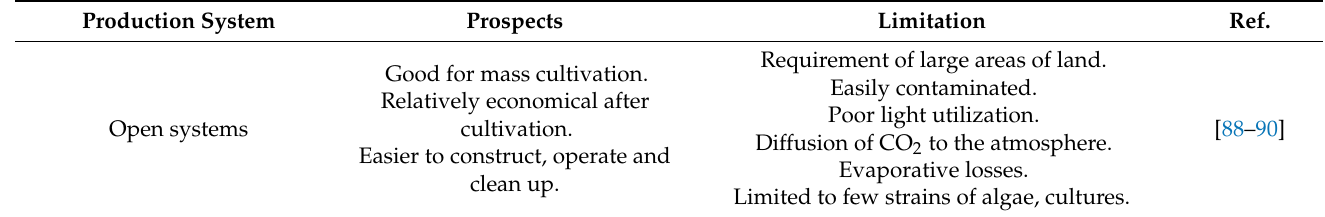
Table 3. Comparison of technologies for microalgae-mediated CO 2 biosequestration. Production